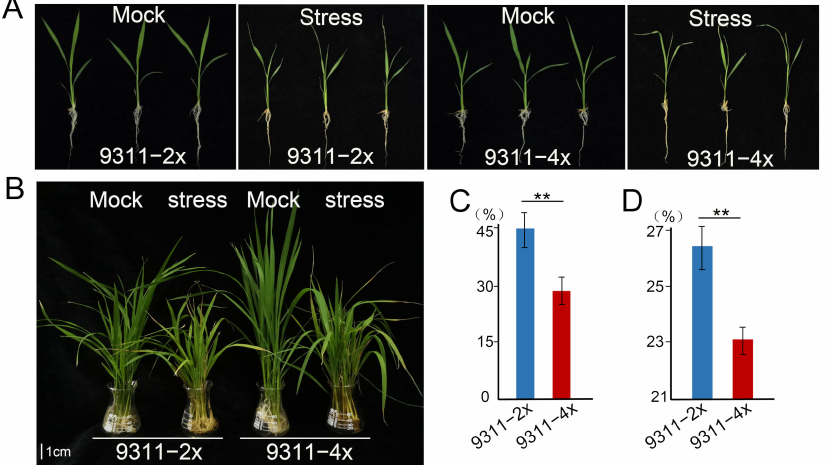
Figure 1. Phenotypic variations in response to alkaline stress in 9311-2x and 9311-4x rice